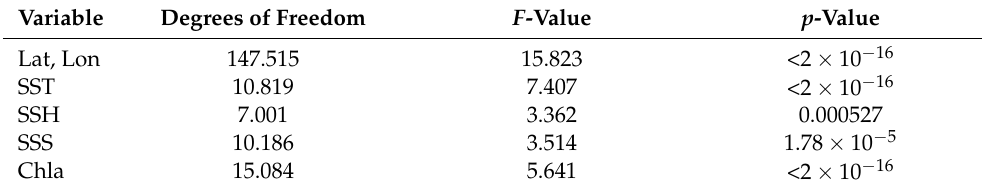
Table 2. F -test for significance of non-parametric